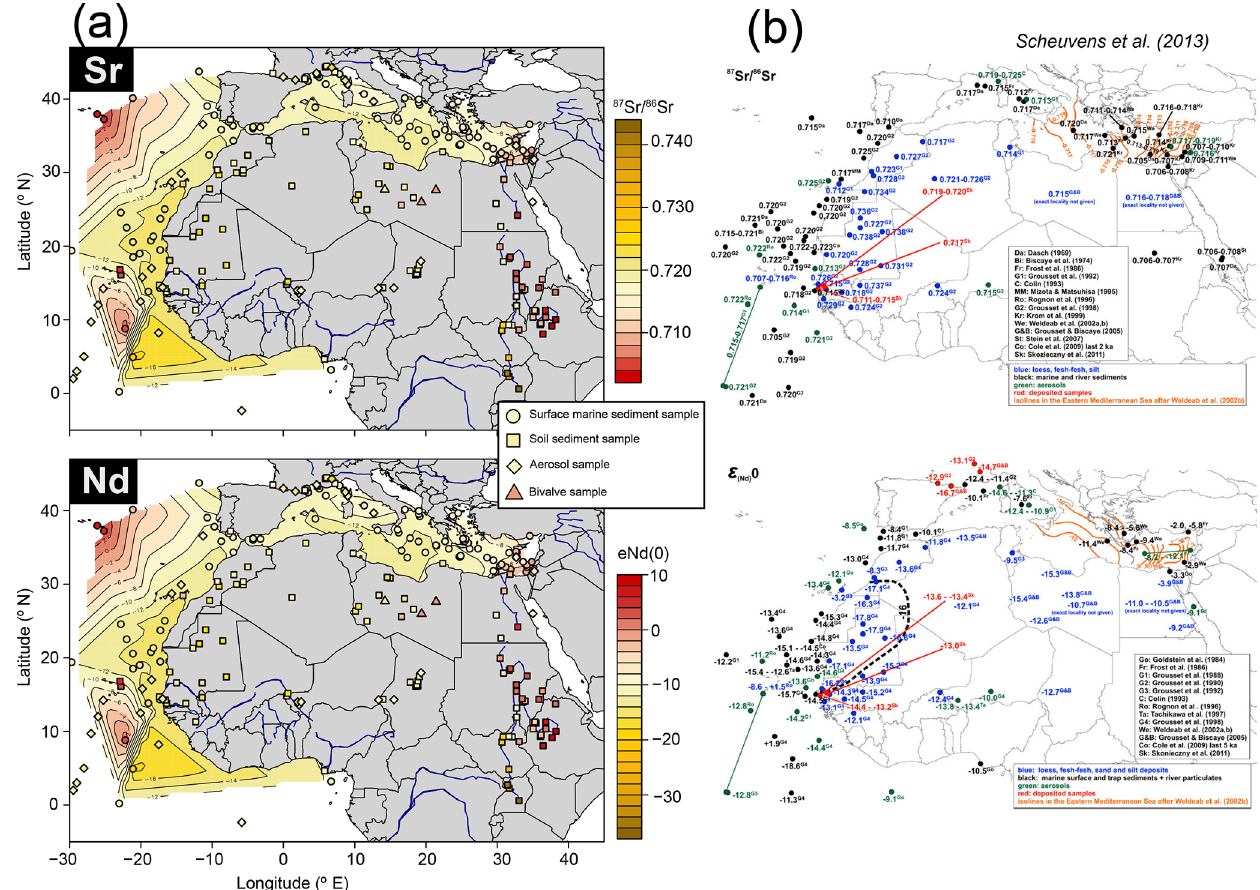
Figure 3. Contour maps of the isotopic signature of marine and terrestrial sediment in the northern African sector realized using the first iteration of the database (September 2018). (a) Comparison of the isotopic signature of marine surface sediments (contour maps) to that of terrestrial samples. Sample type is indicated by specific markers, whose colour indicates its isotopic value according to the scale to the right of the panels: dots for marine surface sediments, squares for terrestrial (soil and river) sediment samples, and diamonds for aerosols and triangles for fossil bivalves. (b) Maps from Scheuvens et al. (2013), which were inspirational to this work. The sample type is given by the colour of the markers: blue for terrestrial samples, black for marine samples, green for aerosols (sediment traps) and red for deposited samples. Isotopic values are reported for each sample and the isolines from Weldeab et al. (2002b; cf. Fig. 3) are also